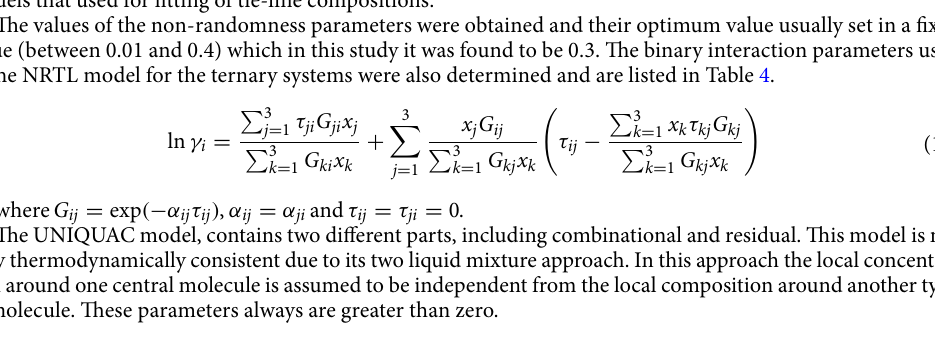
The non-random two-liquid (NRTL) 47 and universal quasi-chemical (UNIQUAC) 48 are the local composition models that used for fitting of tie-line compositions. The values of the non-randomness parameters were obtained and their optimum value usually set in a fixed value (between 0.01 and 0.4) which in this study it was found to be 0.3. The binary interaction parameters used in the NRTL model for the ternary systems were also determined and are listed in Table 4.